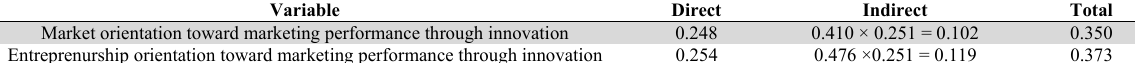
Fifth Hypothesis SEM Test Results. Market orientation and entrepreneurship orientation towards marketing performance through innovation Variable